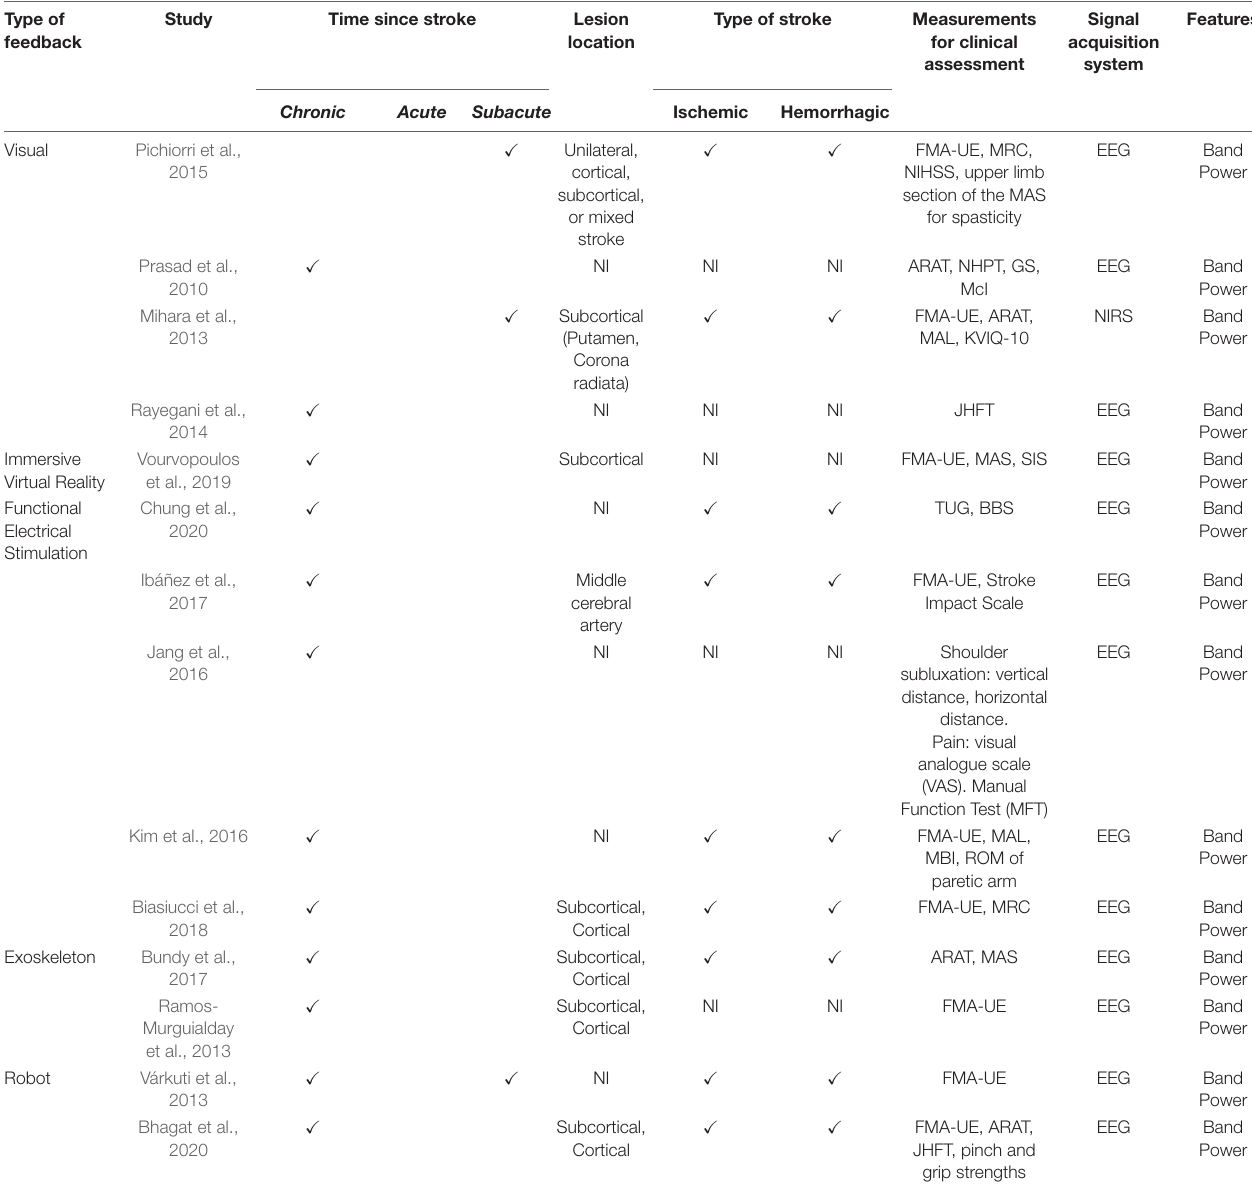
TABLE 2 | Summary of types of feedback versus the time since stroke, lesion location, type of stroke, measurements employed for the clinical assessment, signal acquisition system, and features used for classifications. Type of